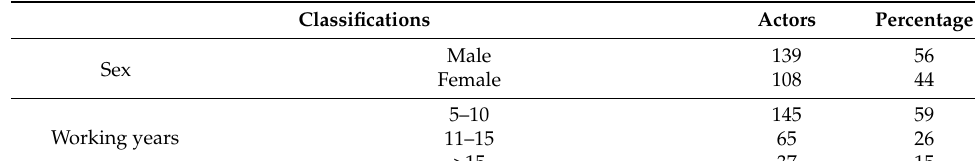
Table 4. Descriptive statistical analysis of the